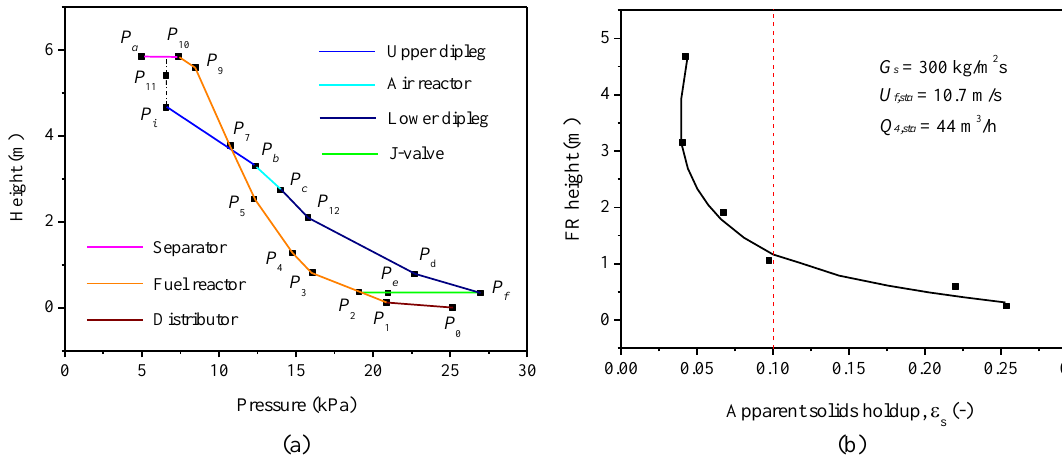
Figure 7. The pressure profile of the whole system and the apparent solids holdup along the FR under the proposed pressure gradient condition: ( a ) pressure profile, and ( b ) apparent solids holdup. Table 2. Pressure gradients and gas leakage ratios under the proposed operation condition (AR: air reactor). Description Measured Calculation Description Parameter Value (%)